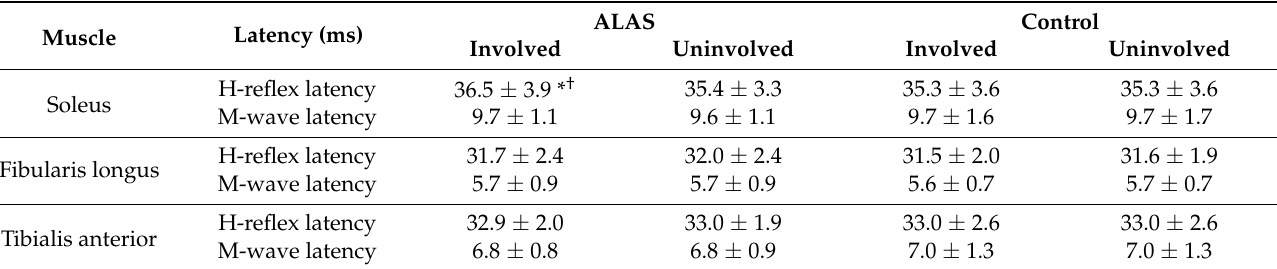
Table 1. Descriptive data of H-reflex and M-wave latencies.